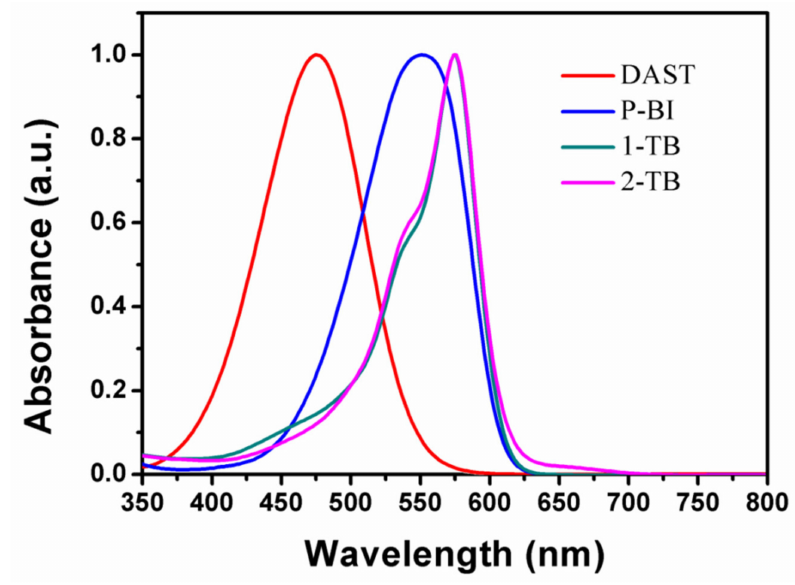
Figure 1. Absorption spectra of DAST, P-BI, 1-TB and 2-TB in